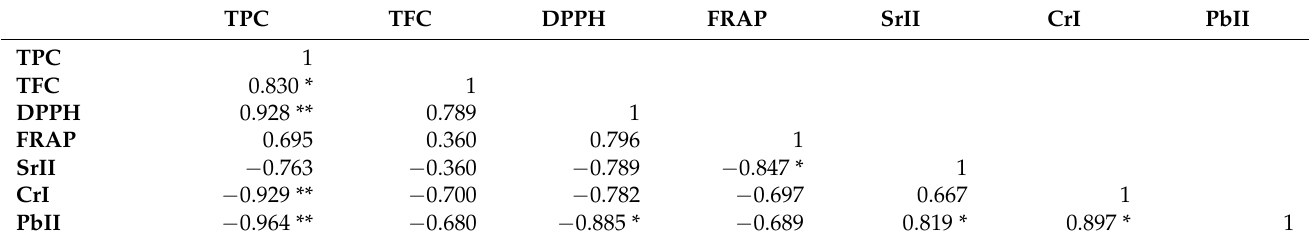
Table 7. Correlation matrix (Pearson correlation coefficients) among the considered parameters.